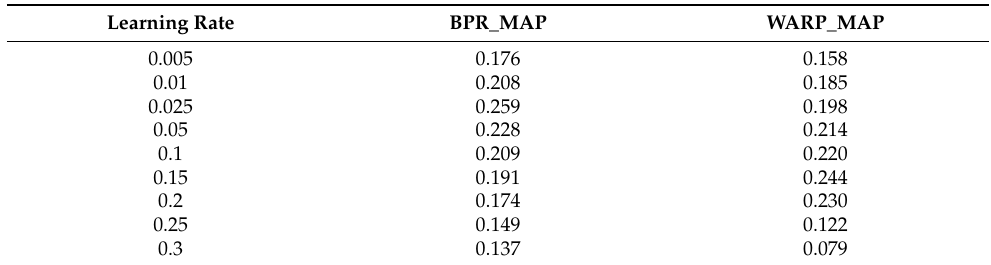
Table 2. Learning rate parameter tuning. This table presents MAP@10 for different parameter values. The remaining parameters are set to the default values according to Table